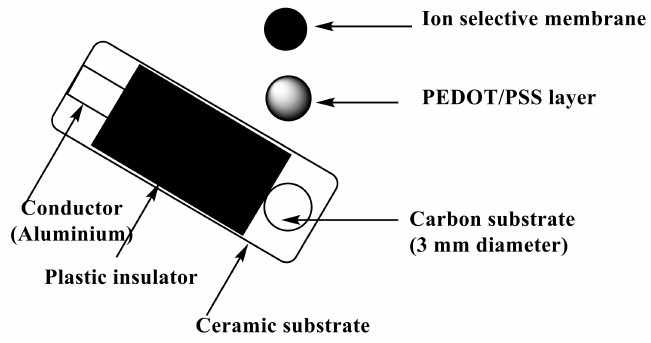
Figure 8. Schematic illustration of fabrication of the potentiometric screen-printed